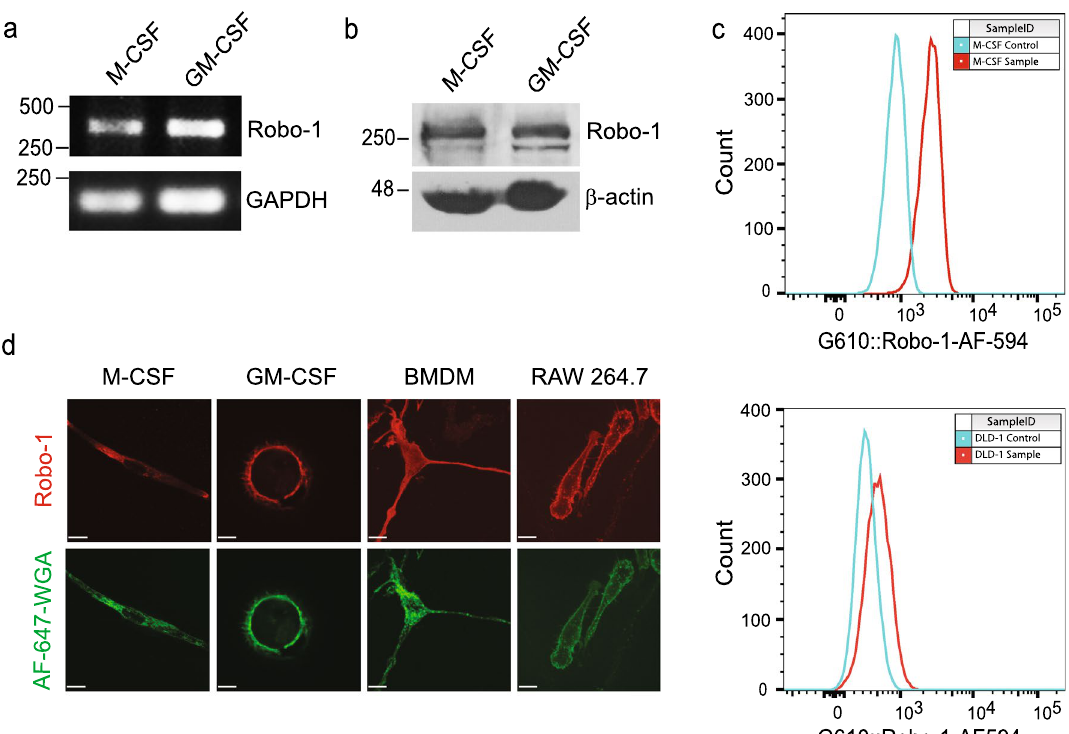
Figure 1. Human and murine macrophages express the Slit2 receptor, Robo-1. ( a ), Human peripheral blood mononuclear cells (PBMC) were isolated and incubated with M-CSF or GM-CSF to generate M-CSF- or GM-CSF-induced macrophages, respectively. RT-PCR was performed using specific primers for Robo-1 and GAPDH. ( b ), Lysates were collected from M-CSF- and GM-CSF-induced human macrophages and immunoblotting was performed using antibodies specifically detecting Robo-1 or ß-actin. ( c ), M-CSF-induced human macrophages (top) and DLD-1 cells (bottom) were first incubated with viability dye followed by AF-594- conjugated secondary Ab (Control, blue peak), or anti-Robo-1 Ab and AF-594-conjugated secondary Ab (Sample, red peak). Data from live, single cells was acquired using an LSRII flow cytometer (BD Biosciences-US) with FACSDiva software (BD Biosciences-US) and analyzed with FlowJo v10 (BD Biosciences-US). ( d ), M-CSF- and GM-CSF-induced human macrophages, murine BMDM and RAW264.7 macrophages were fixed and incubated with anti-Robo-1 Ab, followed by Dylight549-conjugated secondary Ab (red) and AF-647-conjugated wheat germ agglutinin (pseudocoloured green). Cells were imaged using a spinning disk confocal microscope at 63× magnification. Scale bar, 10